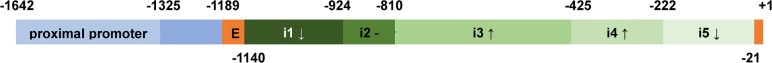
Summary of the shrimp β-actin gene regulatory regions.The regulatory loci identified in this report are designated by ↑ when positive, and ↓ when negative. The numbers indicate the positions (the first base of starting codon ATG was set as position+1).